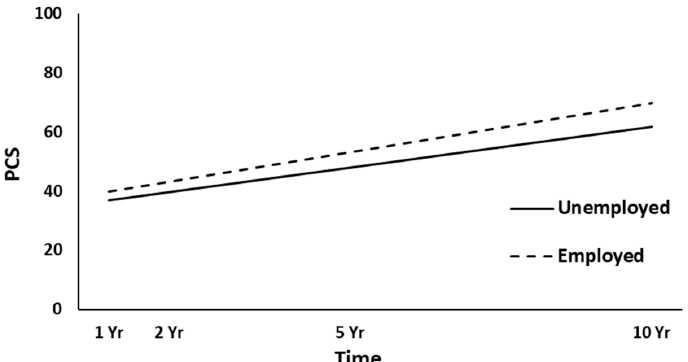
Figure 3. Main effect of employment at admission on the physical health (PCS) trajectories. yr, year.